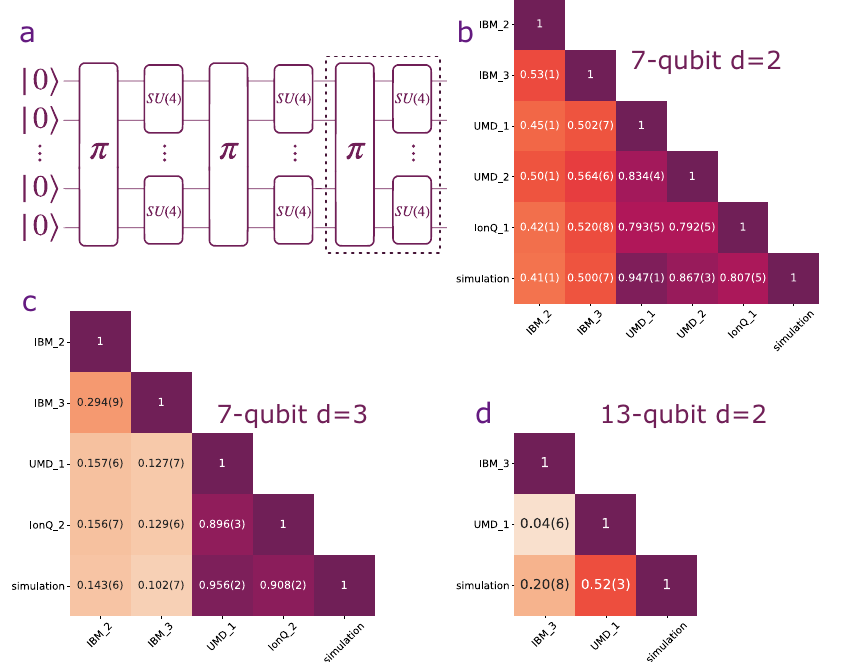
Fig.2|Thecross-platform fi delityfor7-qubitand13-qubitQV-likecircuit.a The quantum volume circuit diagram for d =3. The d =2 case does not have the operations in the dashed rectangle. b – d Cross-platform fi delity between different